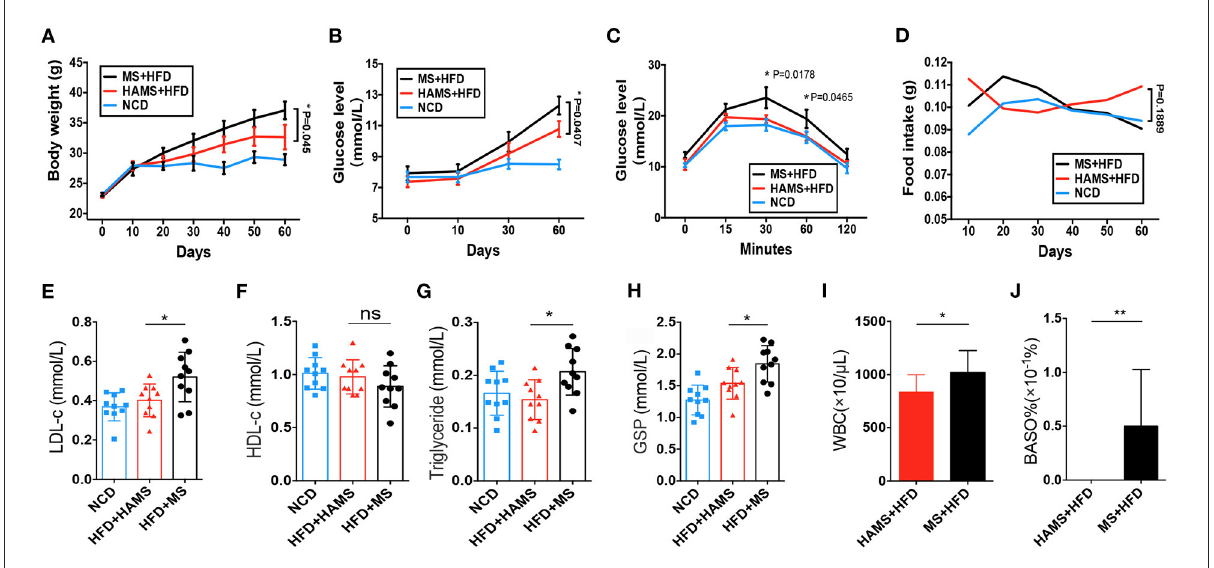
FIGURE2 HAMS ameliorates HFD-induced hyperglycemia. (A) Body weight data from NCD, HAMS, and MS mice ( n = 10 biologically independent animals per group, the data are presented as the median ± SEM, * P < 0.05). Since each group had data at 4 different time points, we used two-way ANOVA with the Bonferroni post hoc test method to compare the HAMS group and the MS group. (B) Blood glucose levels in HAMS and MS mice after HFD and NCD ( n = 10 biologically independent animals per group, the data are presented as the median ± SEM, * P < 0.05). We used two-way ANOVA with the Bonferroni post hoc test method to compare the HAMS group and the MS group. (C) Blood glucose levels in HAMS and MS mice after glucose injection ( n = 10 biologically independent animals per group, the data are presented as the median ± SEM, * P